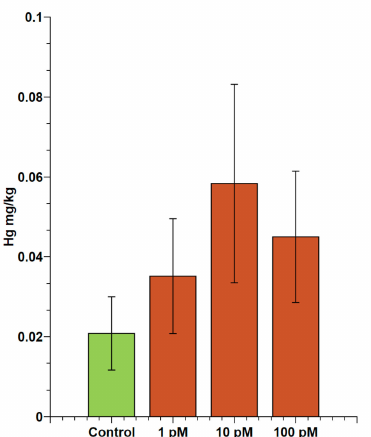
Figure 1. ICP-MS analyses of mercury bioaccumulation in gonads of M. galloprovincialis . Mercury concentration was evaluated after 24 h of exposure of mussels to 1, 10, and 100 pM HgCl 2 in laboratory tanks. The values are expressed based on the wet weight basis. All values represent the mean ± S.D. obtained from 6 gonads of mussels from the same tank.